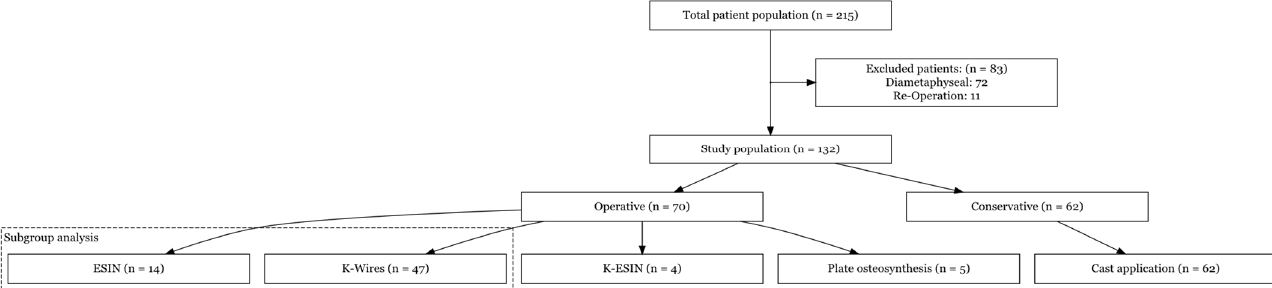
Figure 2. Flow chart of patient enrollment.